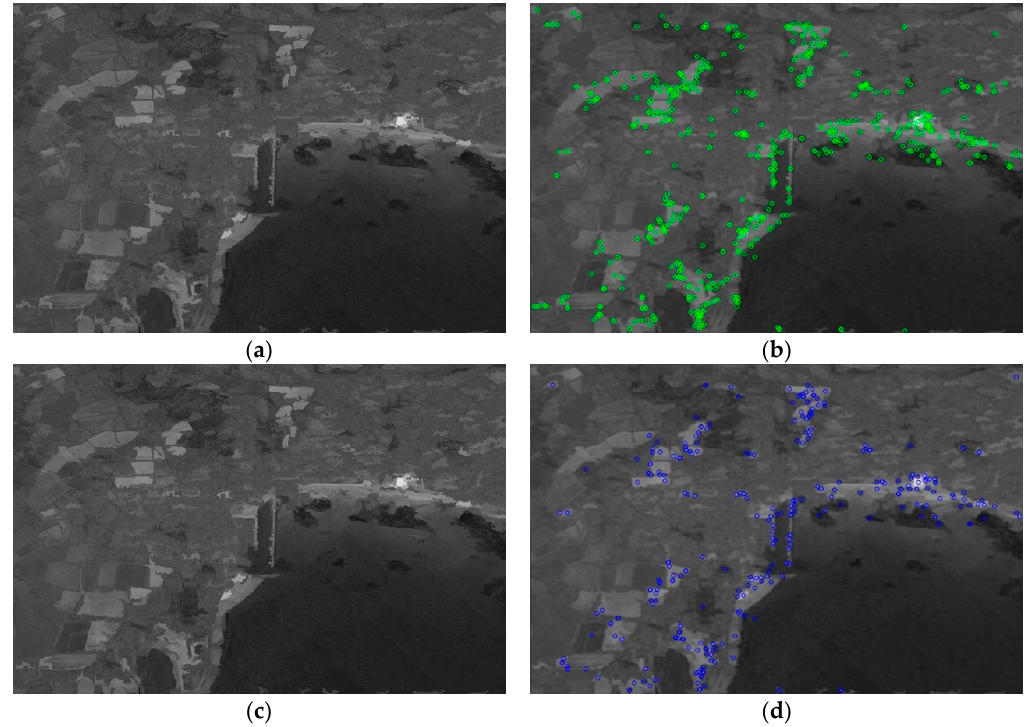
Figure 4. ( a ) Original image. ( b ) Traditional scale-invariant feature transform (SIFT) keypoints extraction. ( c ) Original image. ( d ) EC-SIFT keypoints extraction.